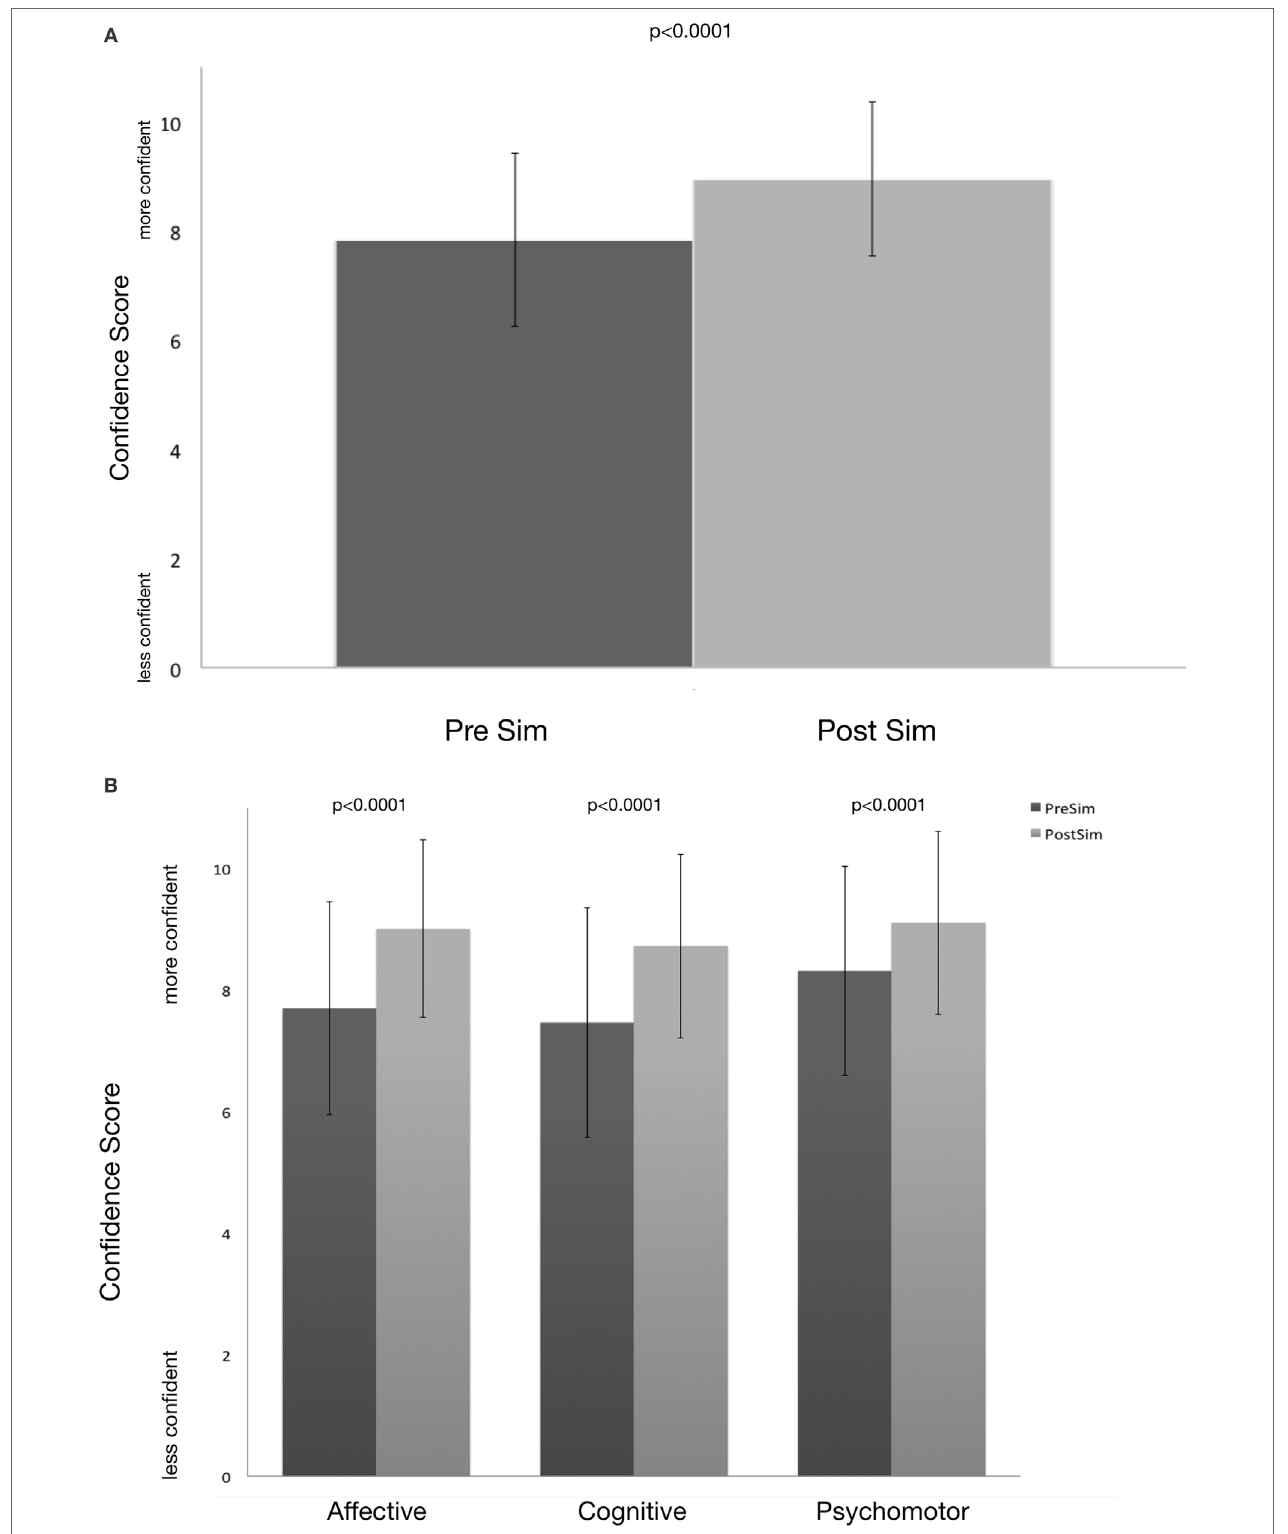
FigUre 2 | (a,B) Pre- and post-learner confidence in management of postpartum hemorrhage (value ± S.D . ) Questions were categorized into one of three domains of Bloom’s Taxonomy. Pre and post survey consisted of four psychomotor questions, six cognitive questions, and five affective questions. Following the screen- based simulation experience, significant gains in confidence were seen in each of the domains (B) as well as the combined overall confidence score (a) .